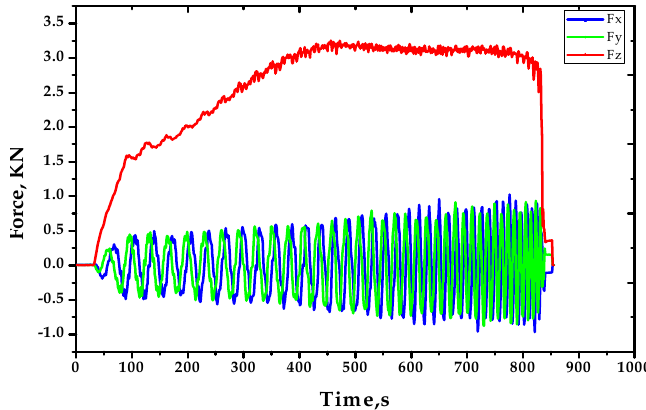
Figure 9. Fracturing of sample at the end of the eight experiments via the SPIF (single-point incremental forming): ( a ) run 1; ( b ) run 2; ( c ) run 3; ( d ) run 4; ( e ) run 5; ( f ) run 6; ( g ) run 7; and ( h ) run 8.